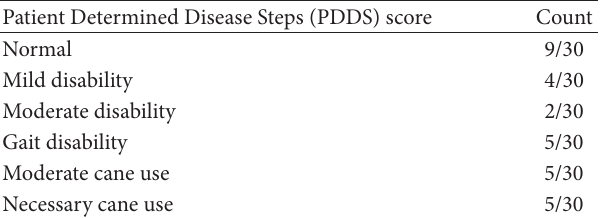
Table 1: Patient determined disability status. Normal: some mild sensory symptoms. Mild disability: noticeable symptoms having a small effect on lifestyle. Moderate disability: no limitation on gait, but significant problems limiting ADLs in other ways. Gait disability: MS interferes with ADLs, particularly gait. Moderate cane use: can walk 25 ft/20 sec without assistance and always needs assistance to walk three blocks. Necessary cane use: assistance required to walk 25